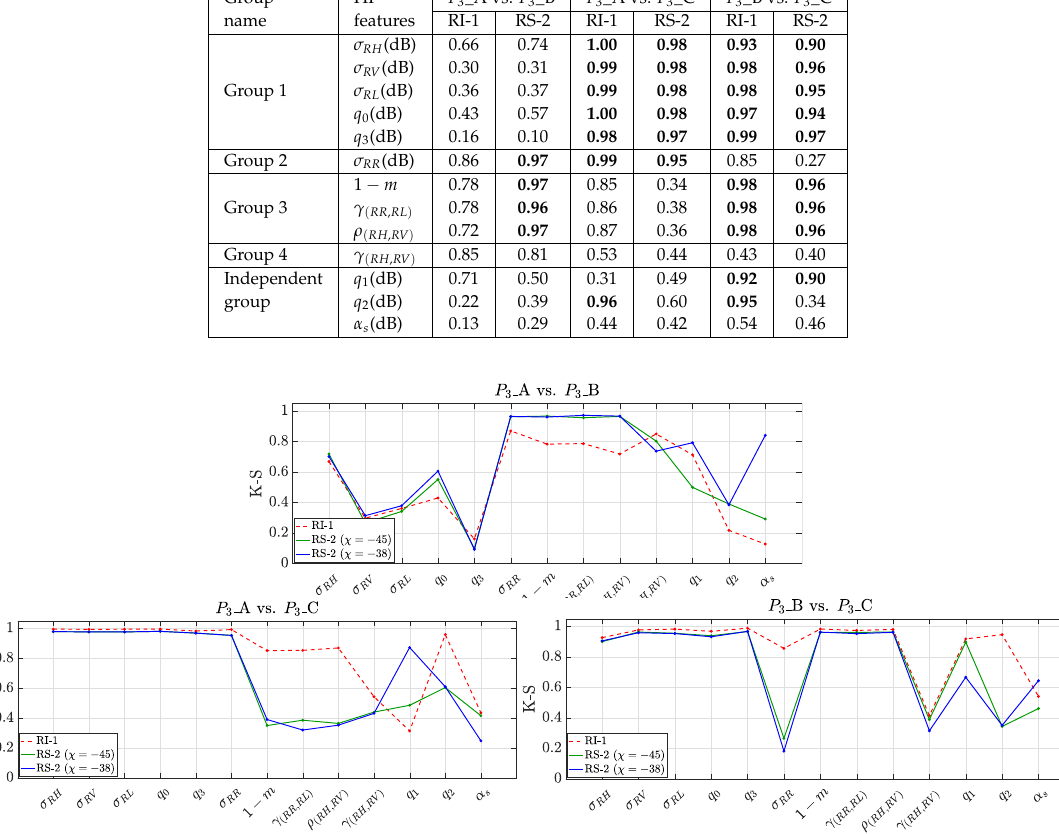
Figure 9. Top panel; a table containing the K-S values between all combinations of paired sea ice types in P 3 . The first column shows groups as described in Table 3. The values greater than 0.9 are in bold. Bottom panels; the corresponding values are shown in the plots, where the y-axis shows the K-S values calculated for each of the paired sea ice types (i.e., ROIs) (red for the RI-1 features and green (blue) for the RS-2 features with an ellipticity angle of χ = − 45 ◦ ( − 38 ◦ )), while the x-axis shows the corresponding features. Note that only the K-S values for RI-1 features and the RS-2 features using an ellipticity angle of χ = − 45 ◦ is shown in the